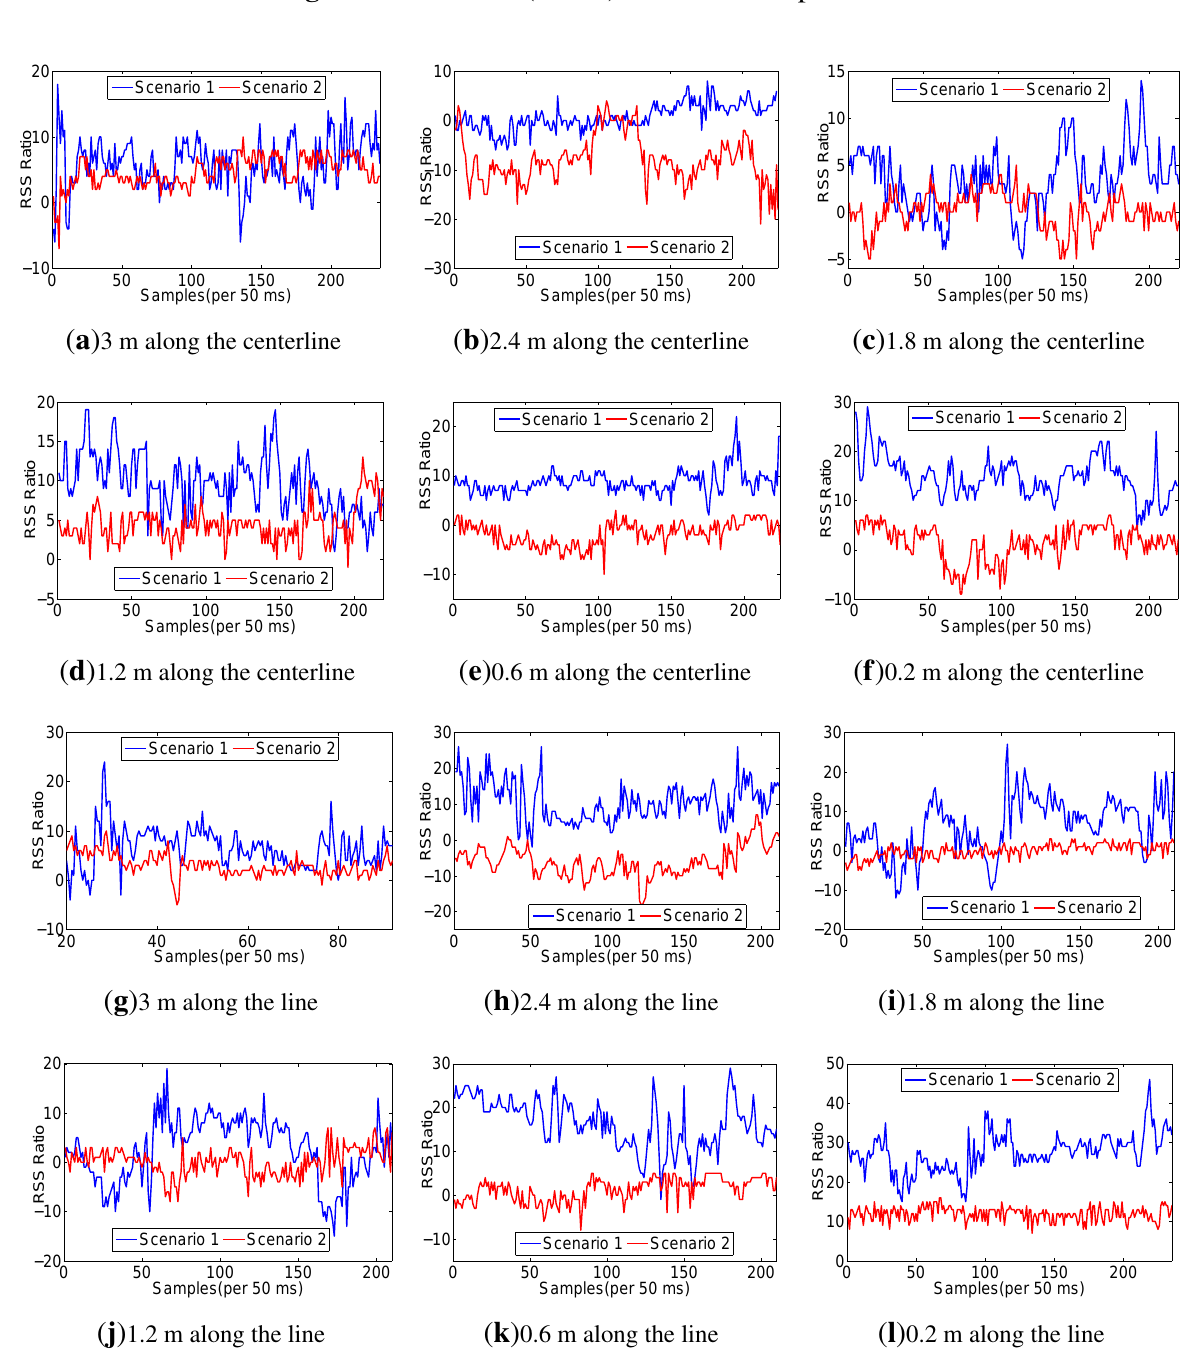
Figure 4. RSS ratio (A-CU) traces in all